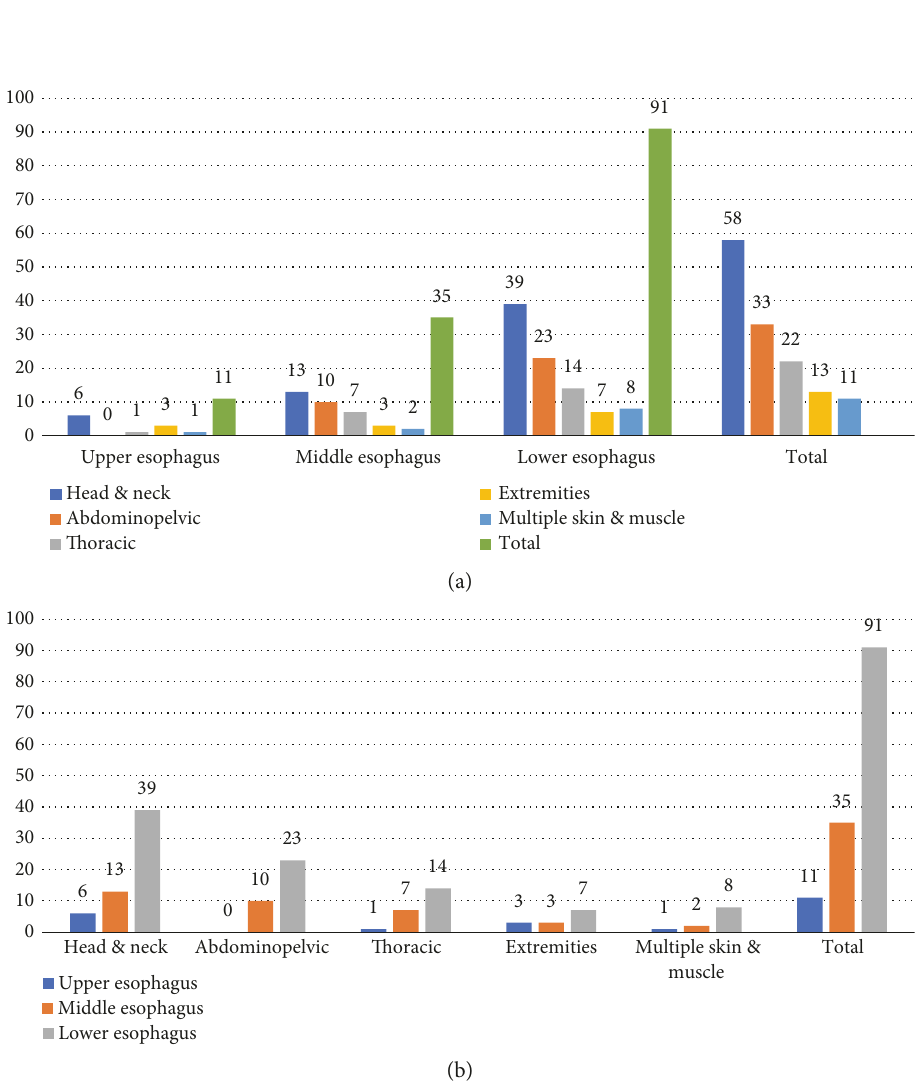
Figure 3: Unexpected ECM trend across organs.